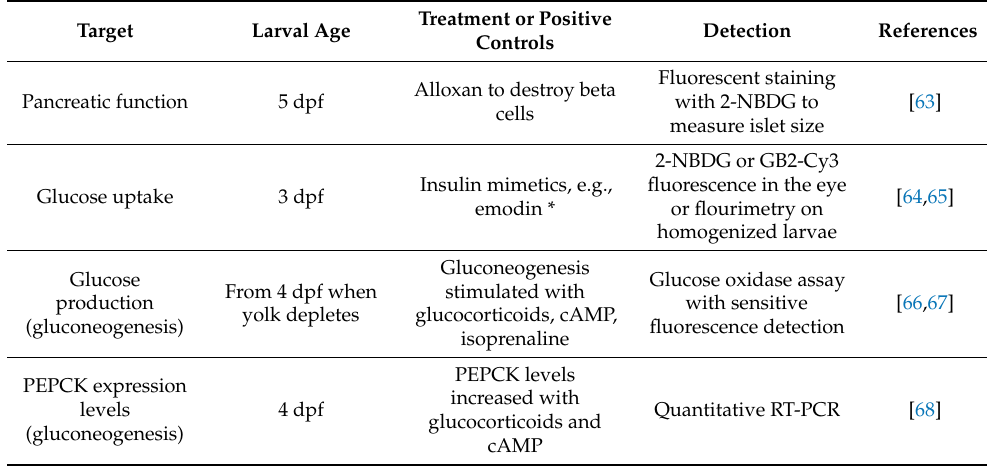
Table 1. Existing methods suitable for antidiabetic activity testing using wild-type zebrafish larvae.